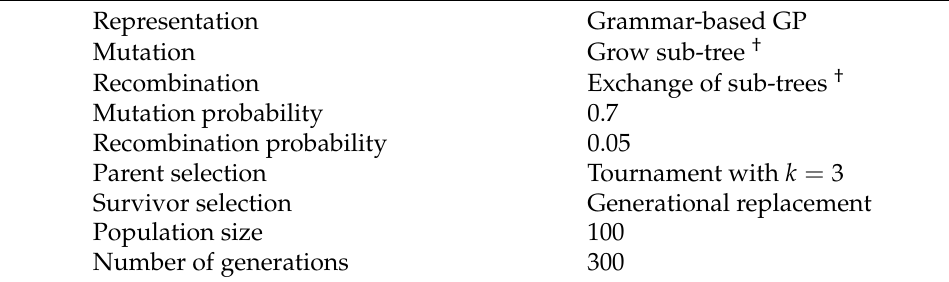
Table 2. Evolutionary hyperparameters.